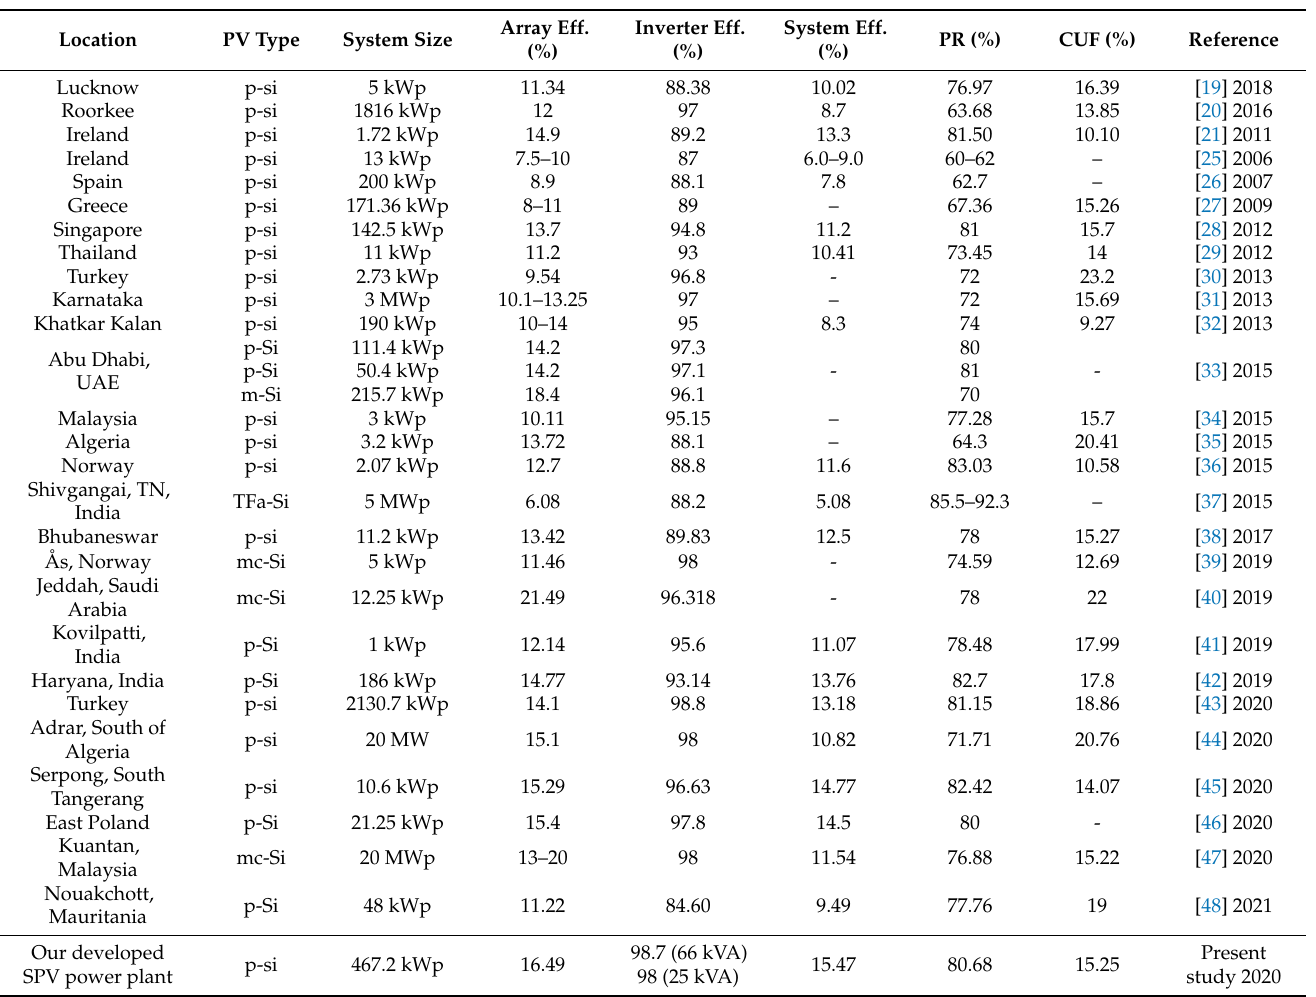
Table 10. Performance parameters of SPV plants reported in published literature compared with installed site at Integral